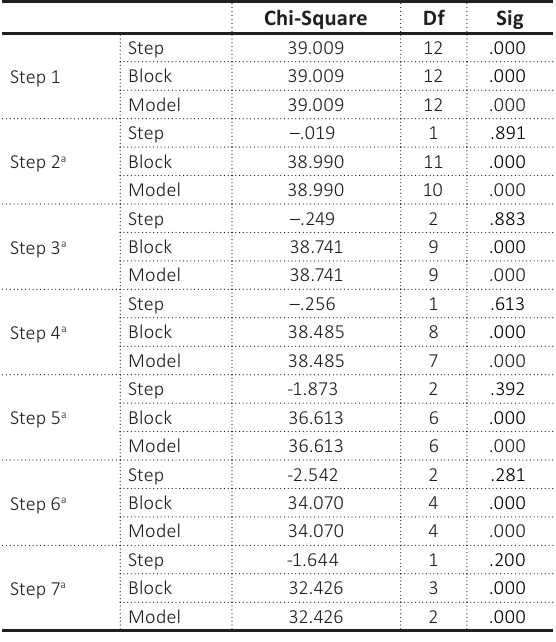
Table 4. Model summary